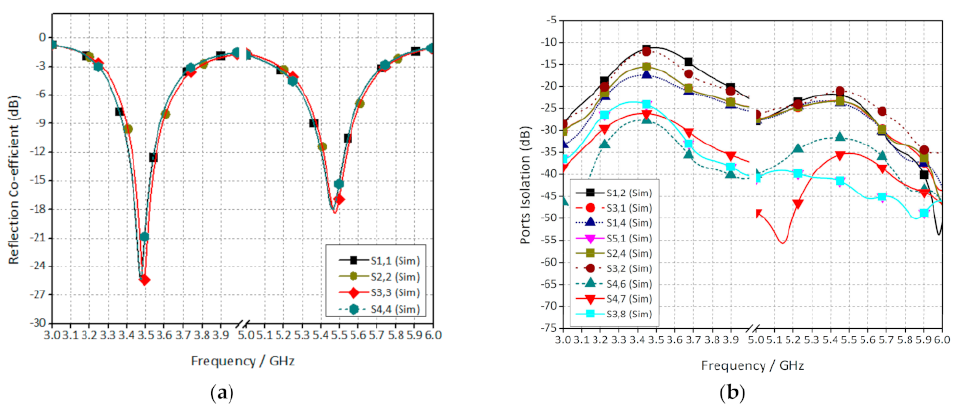
Figure 3. Simulated S-Parameters of Ant1 Ant2 Ant3 Ant4. ( a ) Reflection Coefficient ( b ) Ports